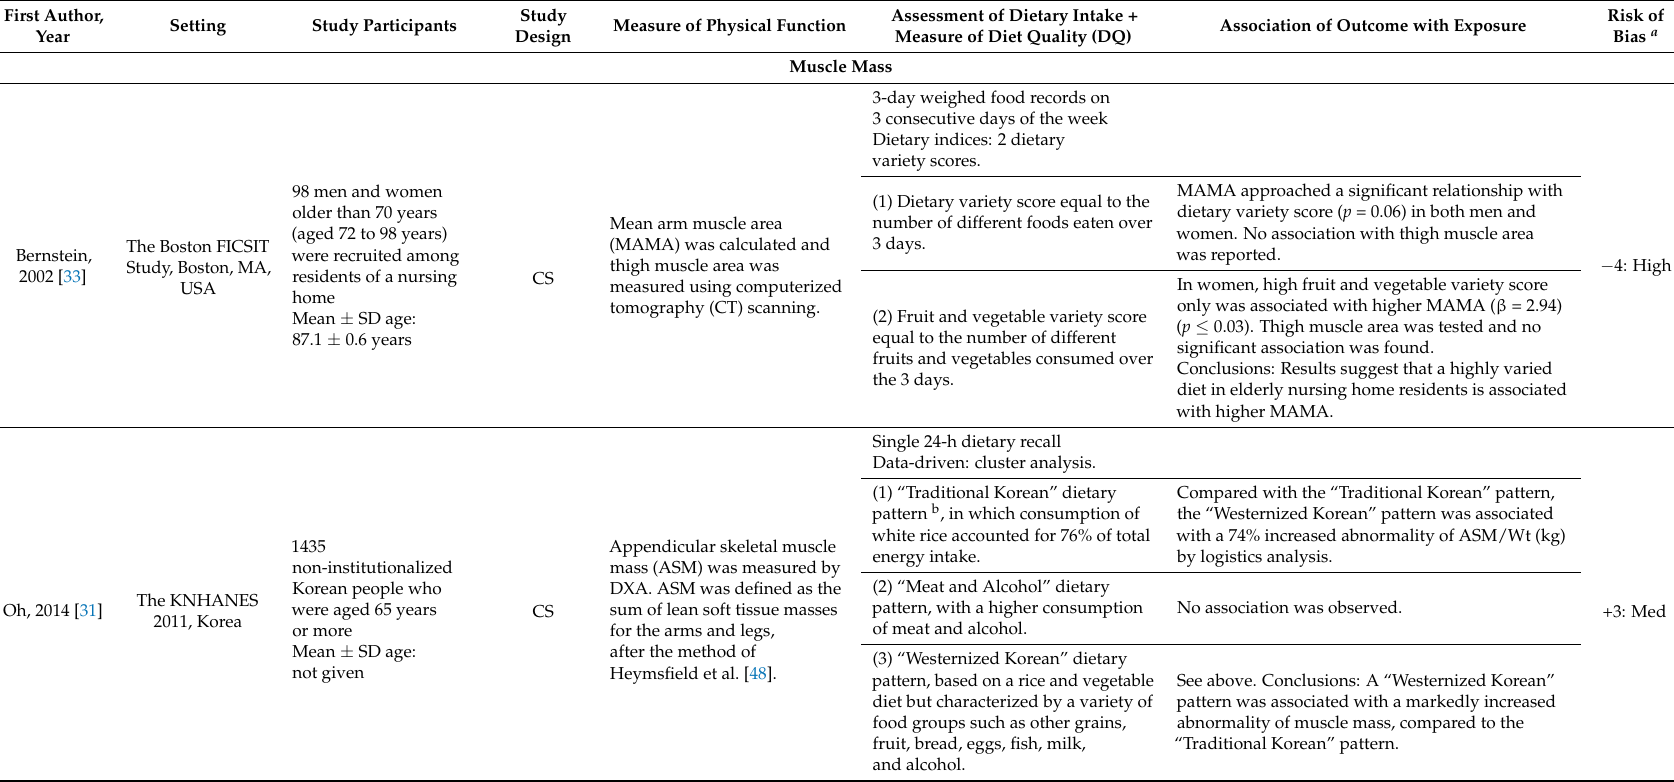
Table 3. Characteristics of studies included in the systematic